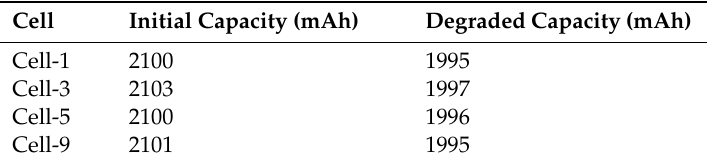
Figure 2. ( a ) Initial capacity distribution (degraded cells). ( b ) Normal probability plot of the initial capacity (degraded cells). ( c ) Initial resistance distribution (degraded cells). ( d ) Normal probability plot of the initial resistance (degraded cells). Table 3. Initial capacity values of the degraded cells.